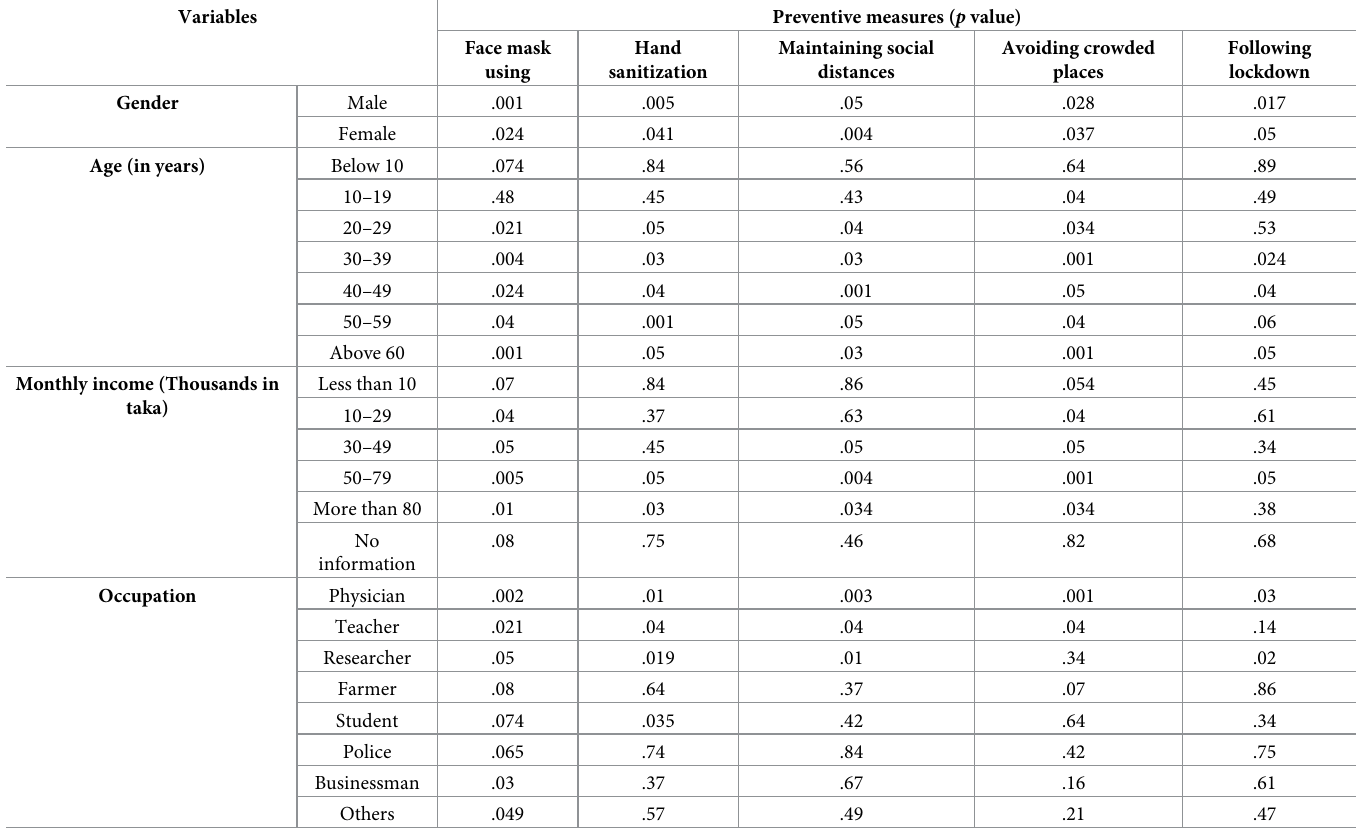
Table 2. Association between the demographic factors and the likelihood of following the preventive